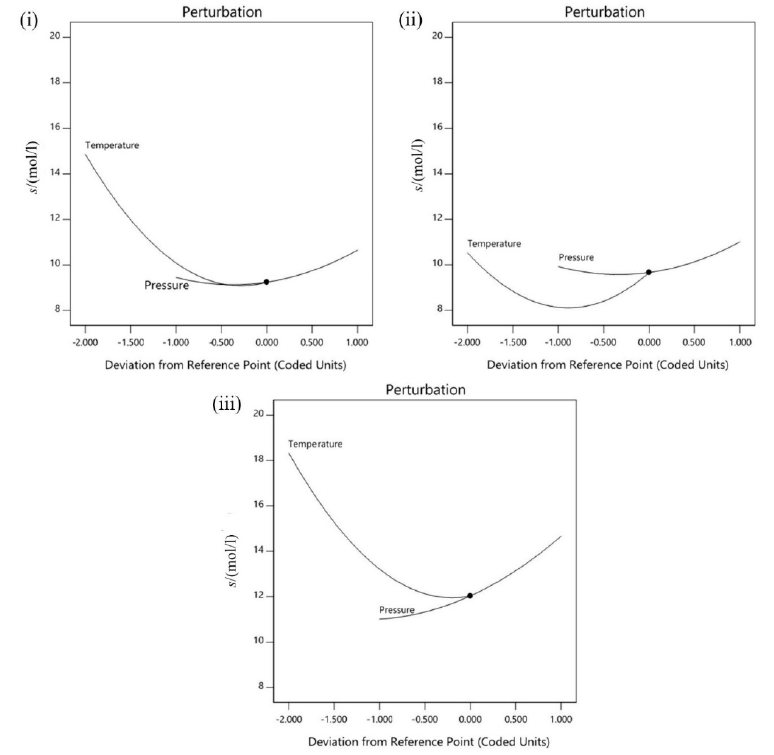
Figure 6. Perturbation plot comparing the response of CO 2 solubility to changes in temperature and pressure in ( i ) pure NaOH, ( ii ) culture media with NaOH, and ( iii ) culture media with monoethanolamine (MEA).